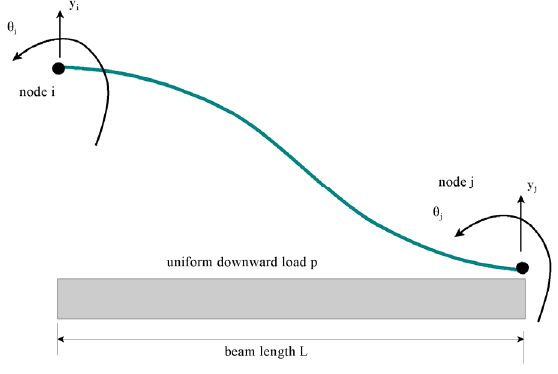
Figure 2. Beam element with bending stiffness.